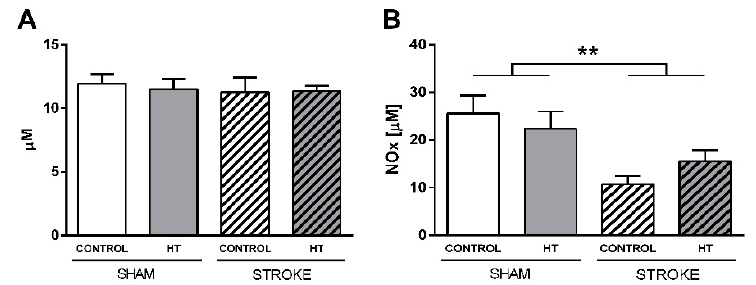
Figure 17. Nitric oxide (NO) and Reactive Oxygen Species (ROS) in serum samples obtained 35 days after surgery. ( A ) ROS level evaluated by analyzing Thiobarbituric acid reactive substances (TBARS) ( B ) NO production quantified by using an ozone chemiluminescence-based assay. A reduction of NO levels was detected in stroke animals ( p < 0.002). Values represent mean ± SEM. ** p < 0.01.